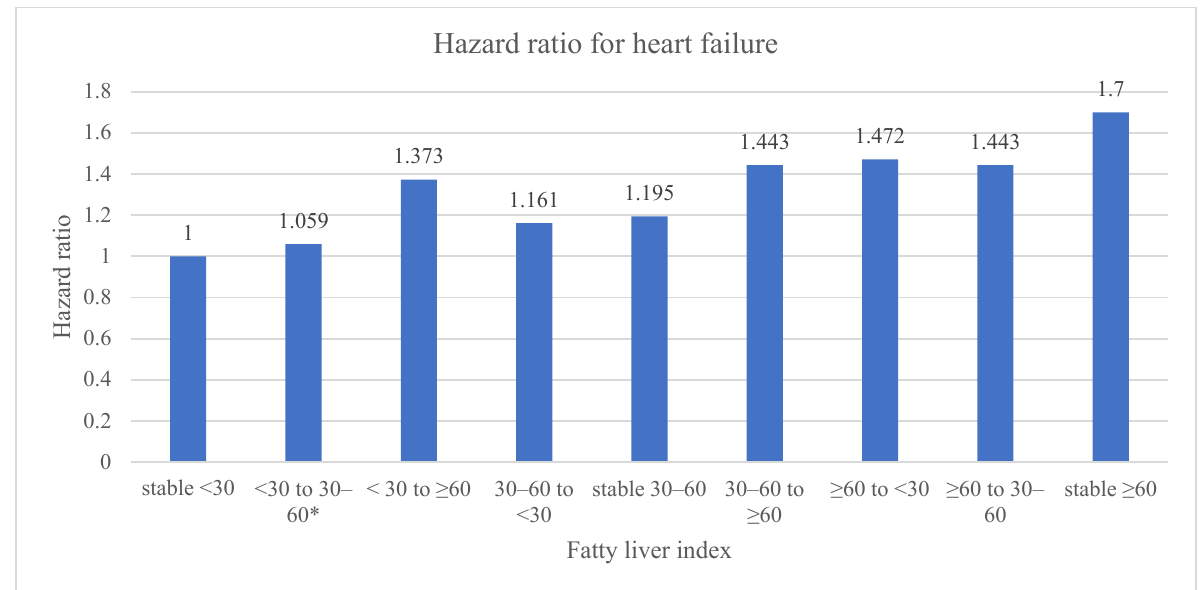
Figure 2. Change in fatty liver index and its hazard ratio for the incidence of heart failure during the four-year follow-up. * Statistically not significant. Adjusted for age, gender, smoking, drinking, exercise, diabetes mellitus, hypertension, dyslipidaemia, and body mass index.